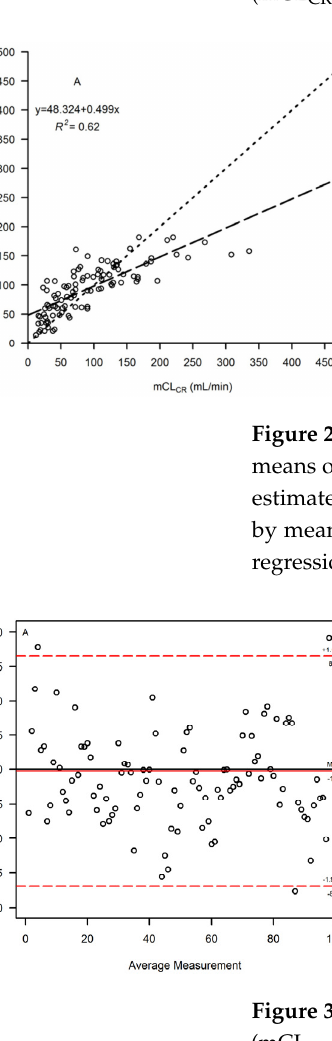
Figure 3. Bland–Altman plot for assessing the agreement between ( A ) measured creatinine clearance (mCL CR ) vs. estimated glomerular filtration rate (eGFR) calculated by means of the CKDEPI formula (eGFR CKDEPI ), ( B ) mCL CR vs. eGFR estimated by means of the Cockcroft–Gault formula (eGFR CG ), and ( C ) mCL CR vs. eGFR estimated by means of the MDRD formula (eGFR MDRD ). The red dashed lines represent the average difference and the 95% C.I. for the average